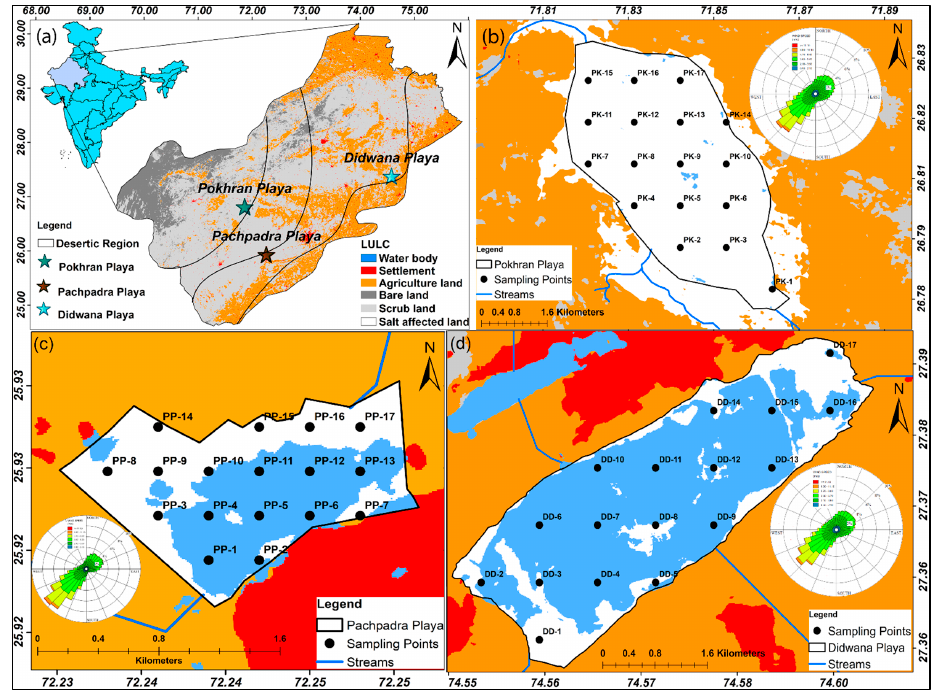
Figure 1. Location map of the study area and the morphological features around the Playas ( a ) Thar Desert, ( b ) Didwana Playa, ( c ) Pachpadra Playa, and ( d ) Pokhran Playa. The map was created in ArcGIS v10.6, and LULC-2019 data were downloaded from ESRI [43].